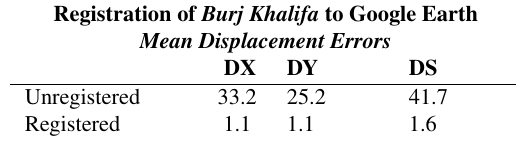
Table 3: Quantitative evaluation results after the registration of the Burj Khalifa satellite video dataset to an image mosaic ac- quired from Google